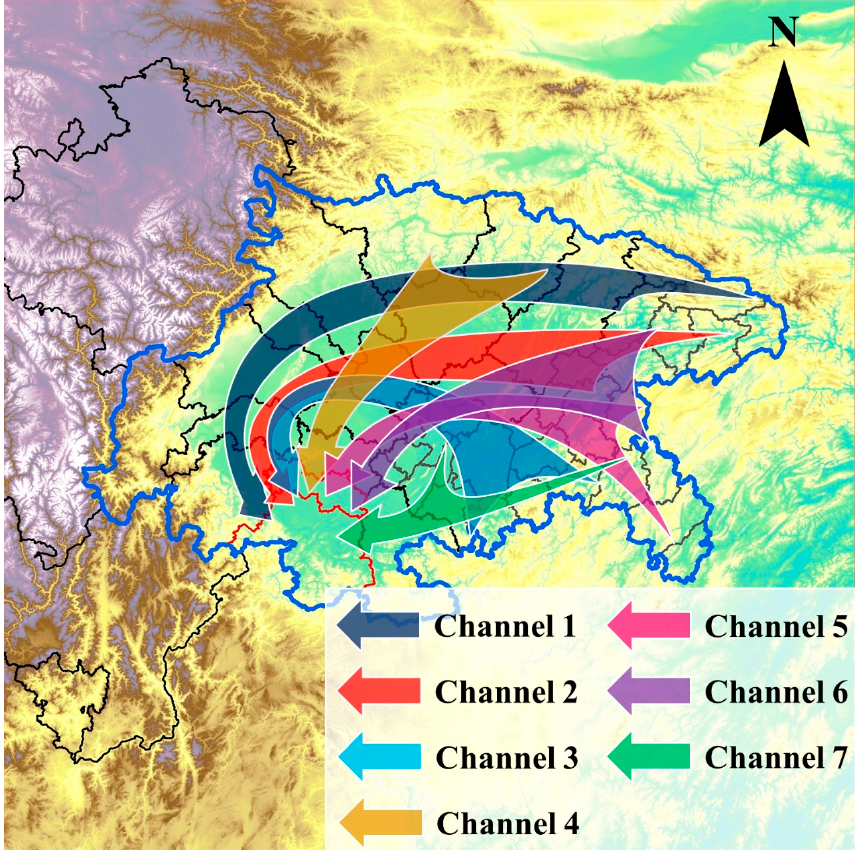
Figure 4. Universal transport channels a ff ecting the receptor cities.